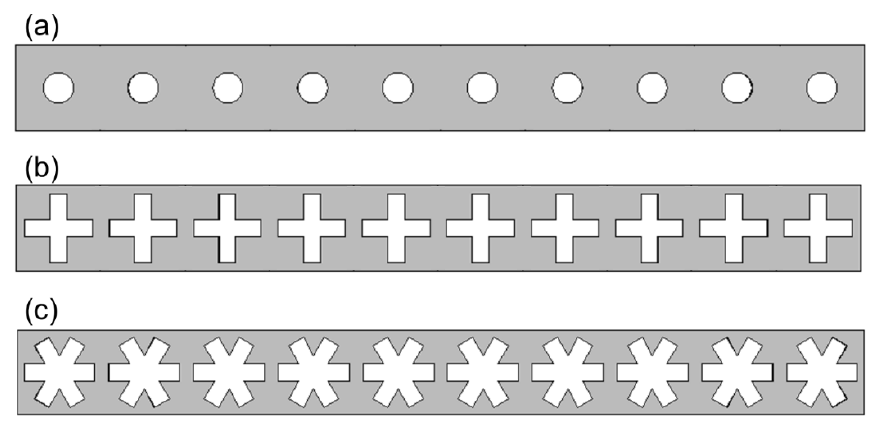
Figure 7. Supercell of the ( a ) circle, ( b ) cross, and ( c ) snowflake shaped graphene phononic crystal used for the thermal conductivity simulation.